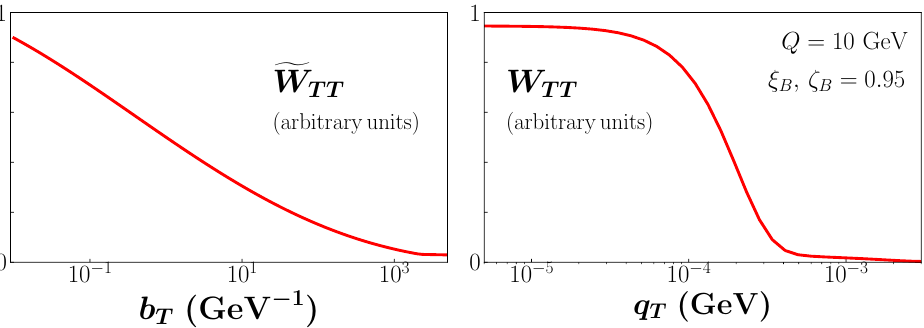
Figure 17 . Shape of the lepton structure function f W TT ( ξ B , ζ B , Q 2 , b T ) (in arbitrary units) in impact parameter space (left) and the corresponding Fourier transform in transverse momentum space W TT ( ξ B , ζ B , Q 2 , ˆ q 2 ) (right) , evaluated at fixed Q = 10 GeV and ξ B = ζ B = 0 . 95 . T space, at fixed values of Q = 10 GeV and ξ = ζ = 0 . 95 . The W function, which B B TT